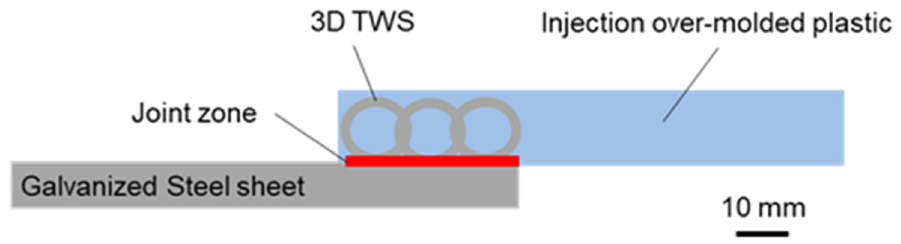
Figure 1. Schematic of the project outcome: A hybrid metal–plastic compound structure with a 3D macroscopic transition zone at the interface.